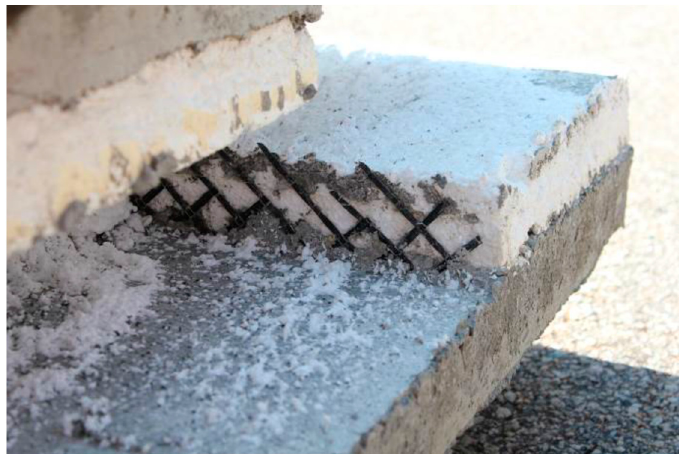
Figure 21. View of ruptured and pulled-out grid.